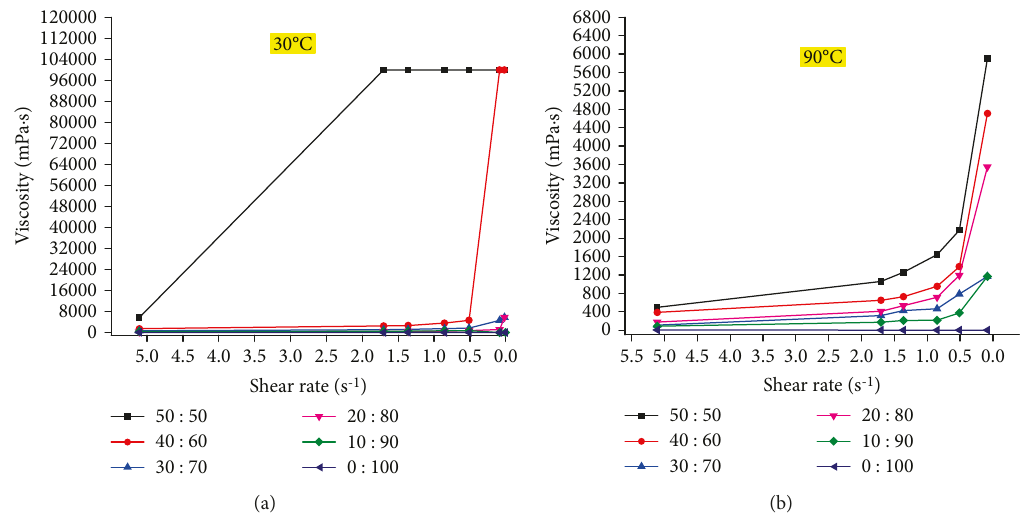
Figure 8: The relationship between shear rate and viscosity at di ff erent